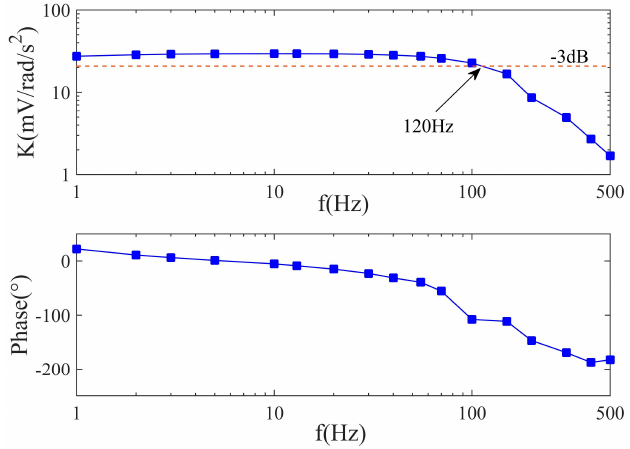
Figure 19. Frequency response of LCAA.